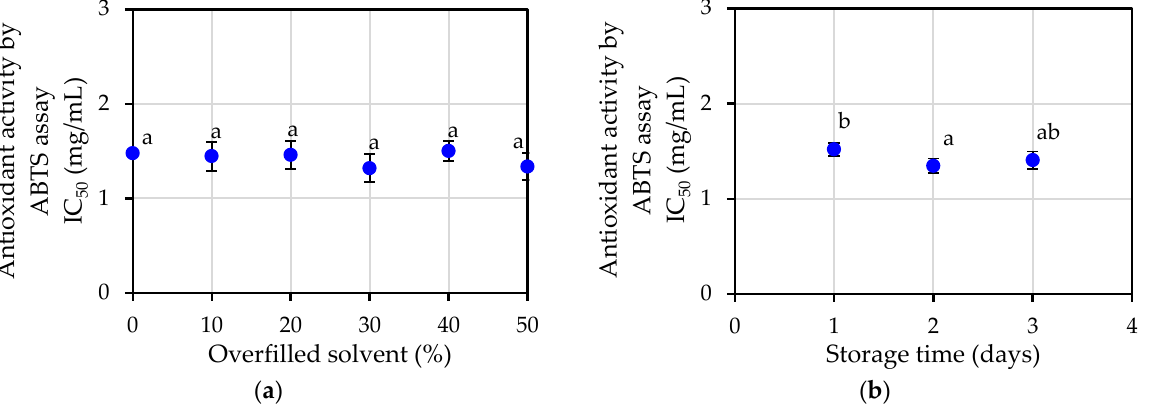
Figure 7. Antioxidant activity by ABTS assay of jasmine essential oil: ( a ) at varying percentage of overfilled solvent; ( b ) at varying storage time. Different letters a, b in the same figure indicate that values are significantly different ( p < 0.05).